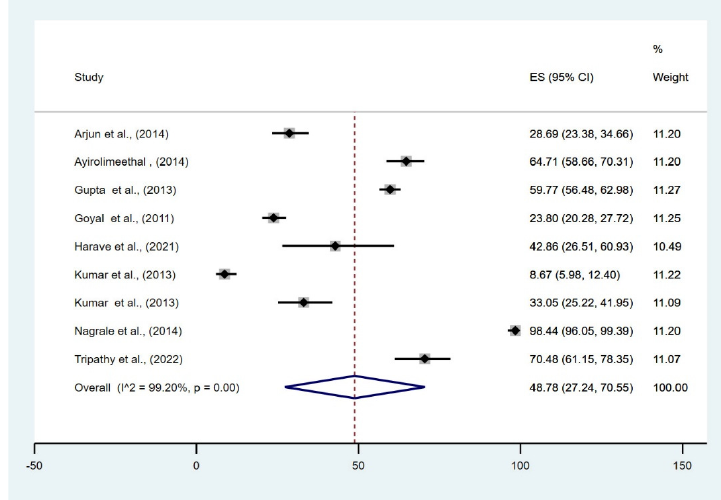
Figure 2. Forest plot of pooled magnitude of NCDs among prisoners of India [1,10–17].